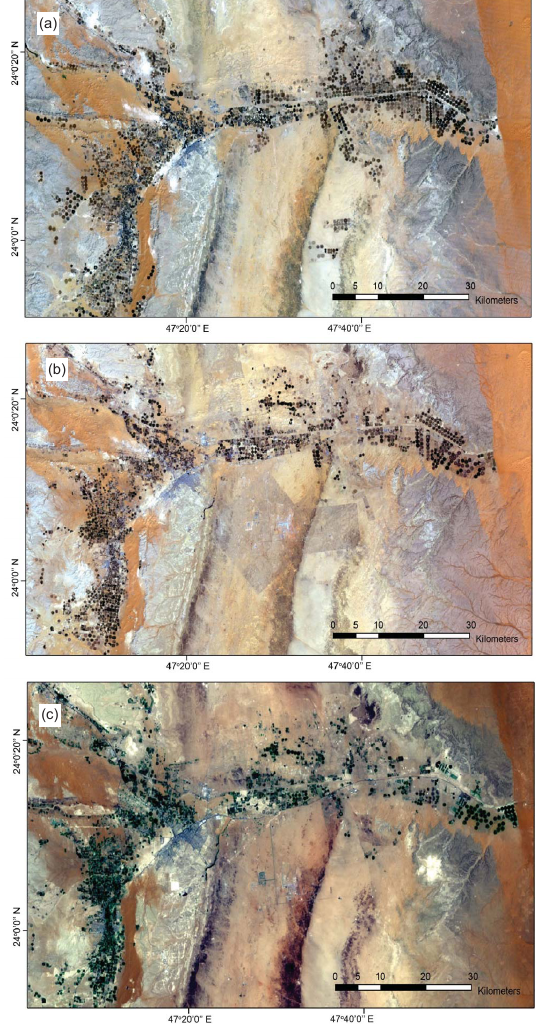
Figure 2. Satellite images of Al-Kharj ecosystem: (a) Landsat4 TM; (b) Landsat7 ETM + ; (c) Landsat8.